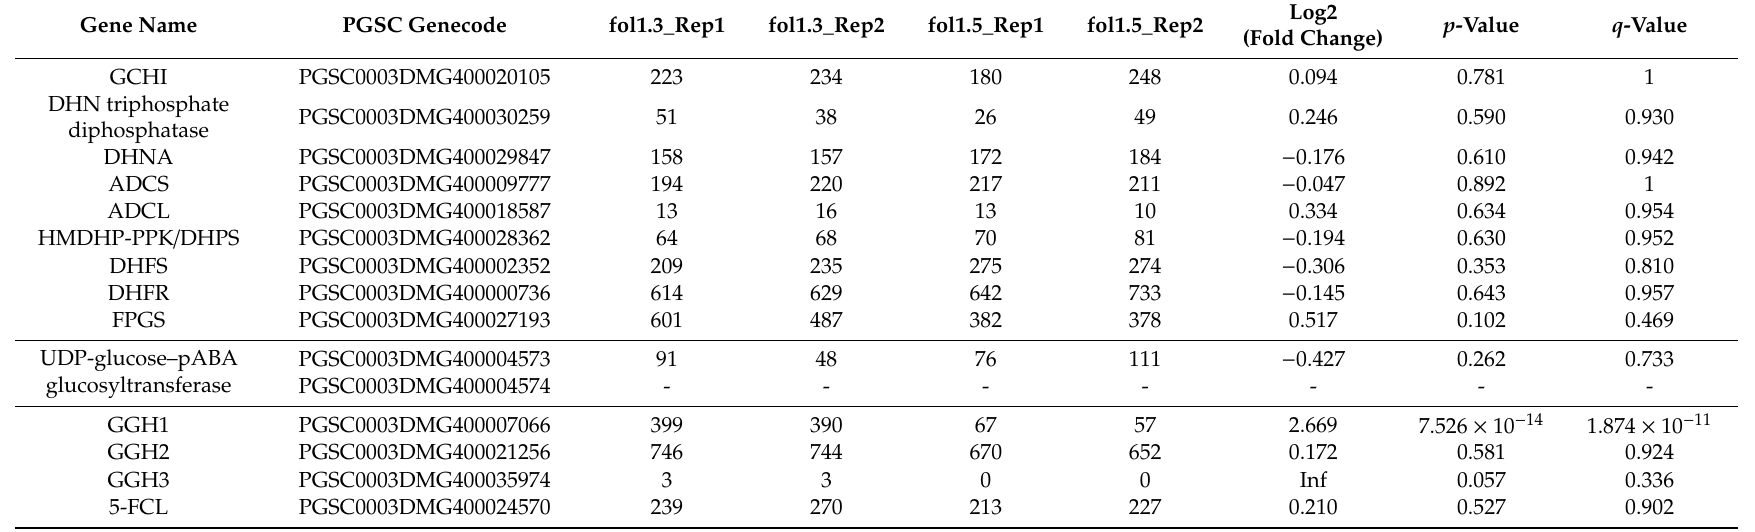
Table 1. Comparison of high and low fol lines (fol 1.3 vs. fol 1.5) based on RNA-Seq analysis. Genes involved in folate biosynthesis are listed with their corresponding PGSC IDs and pseudo counts for those genes as shown in two replicates for each individual. Fold change (log 2 ), p -values, and q -values are calculated for each comparison. In red are Log2 (fold change) > 1.5 or < − 1.5 AND p and q values < 0.05. GCHI, GTP cyclohydrolase I; DHN, dihydroneopterin; DHNA, DHN aldolase; ADCS, aminodeoxychorismate synthase; ADCL, aminodeoxychorismate lyase; HMDHP-PPK / DHPS, 6-Hydroxymethyldihydropterin pyrophosphokinase (HMDHP-PPK) / dihydropteroate synthase (DHPS); DHFS, dihydrofolate synthase; DHFR, dihydrofolate reductase; FPGS, folylpolyglutamate synthase; GGH, γ -glutamyl hydrolase; 5-FCL, 5-formyltetrahydrofolate cycloligase. The closest ortholog of the Arabidopsis UDP-glucose-pABA glucosyltransferase in potato was identified by phylogenetic analyses (Figure